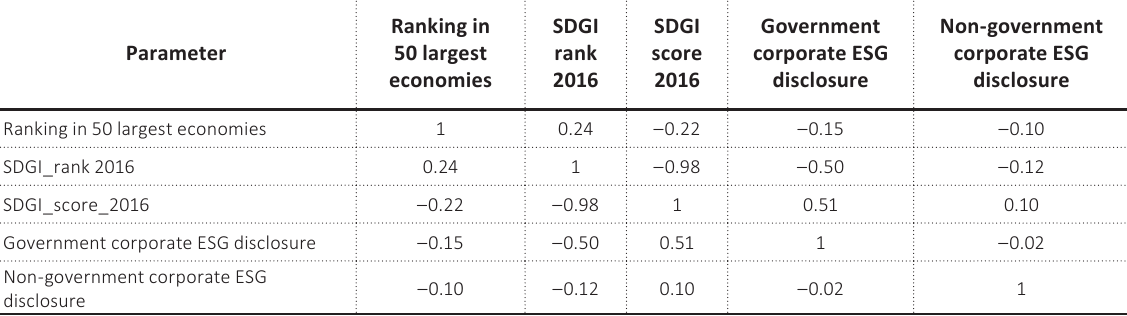
Table D1. Correlation analysis of ESG disclosure regulation and rankings: case of all data sets